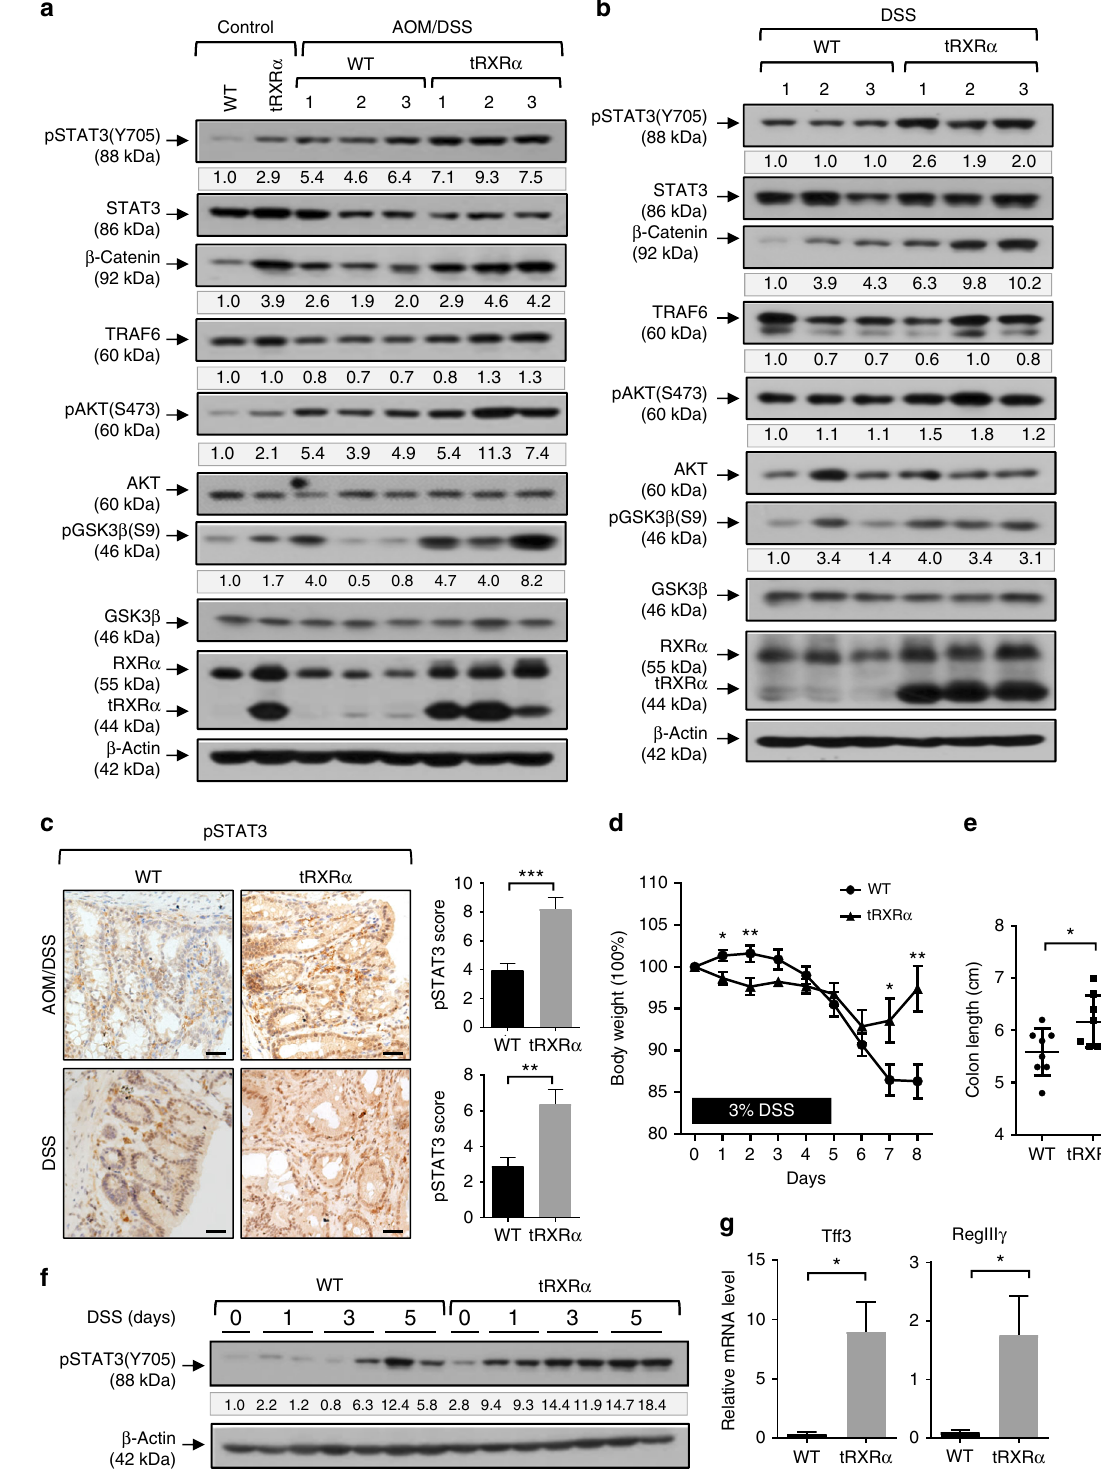
Fig. 2 Activation of signal transducer and activator of transcription factor 3 in colorectal tumors from Tg-tRXR α mice. a , b Colon lysates from mice treated with azoxymethane (AOM)/dextran sodium sulfate (DSS) for 120 days ( a ) or DSS for 6 months ( b ) were analyzed by immunoblotting. The bands are quanti fi ed with Image J and normalized to β - actin. c Colon sections from mice treated with AOM/DSS for 120 days or DSS for 6 months were stained with pSTAT3 antibody and analyzed the staining score. Scale bars, 25 μ m. Data are mean ± SEM ( n = 9), t test. d Body weight curve of control and Tg-tRXR α mice during the course of acute DSS-induced colitis. Data are mean ± SEM ( n = 8), two-way analysis of variance. e Colon length from mice after the course of acute DSS-induced colitis. Data are mean ± SD ( n = 8), t test. f Colonic lysates prepared from mice treated with DSS for the indicated time were analyzed by immunoblotting. g RegIII γ and Tff3 mRNA expression in mice treated with DSS for two days was analyzed by quantitative reverse transcriptase – PCR. Data are mean ± SEM ( n = 3), t test. * P < 0.05, ** P < 0.01, *** P < 0.001. For immunoblotting, one of three or four similar experiments is shown NATURE COMMUNICATIONS| (2019) 10:1463